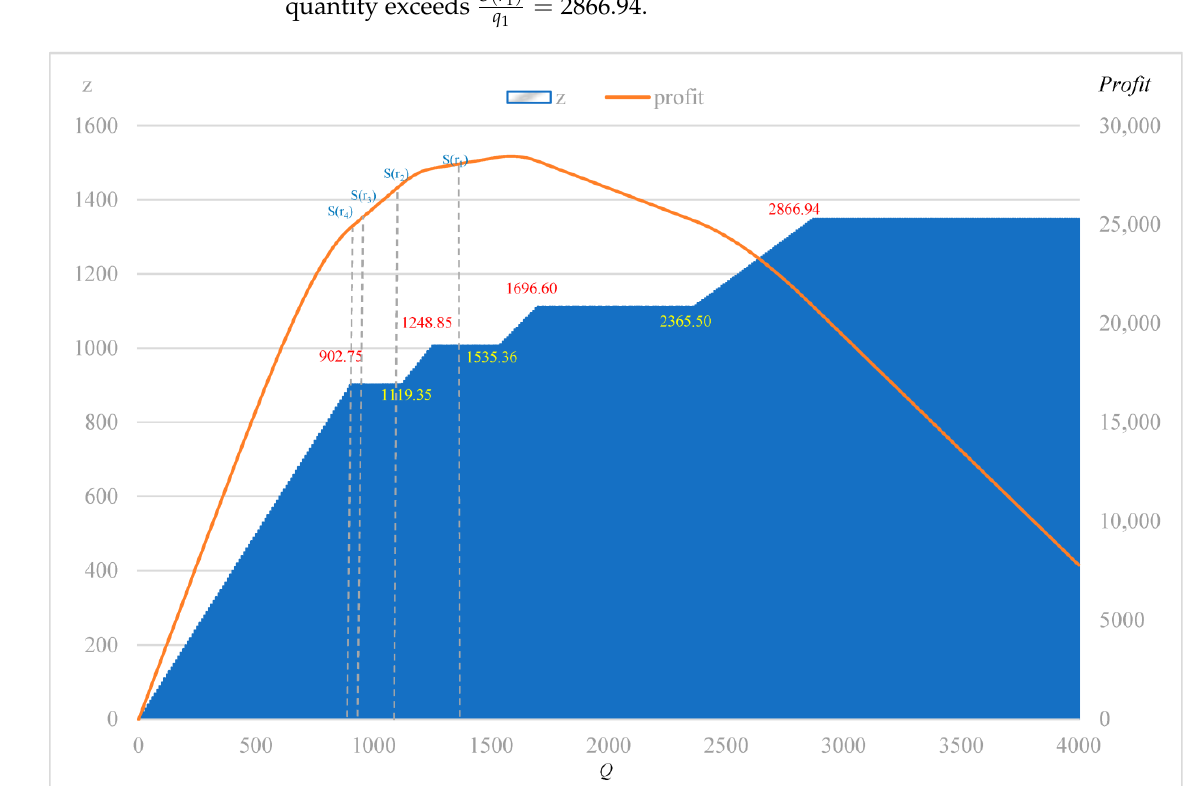
Figure 2. The optimal production quantity z and expected profit π ( Q , z ) .